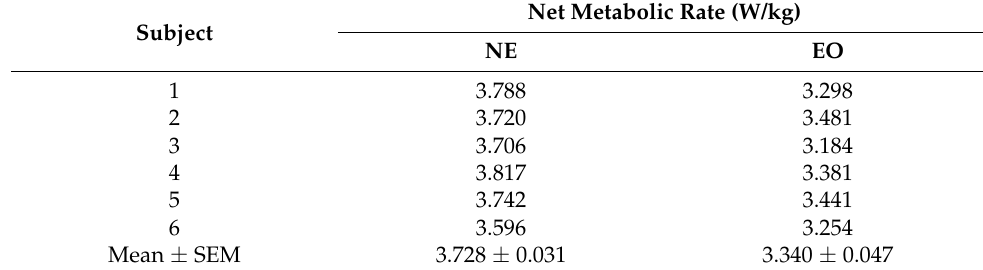
Table 1. Net metabolic rate for each subject in two walking conditions.